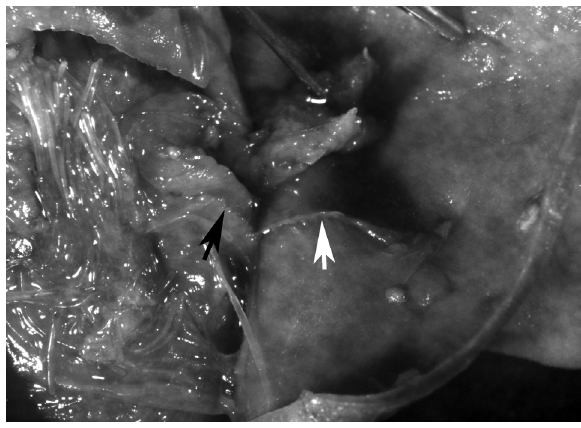
Fig . 6. – Left side of the mantle cavity of Sepiola bursadhaesa n. sp., paratype, MNCN 15.06/226P2, female. The black arrow indicates the shredded line of fusion of the bursa copulatrix to the inner man- tle wall; the white arrow points to the scar of the fusion remaining on the inner mantle wall. Note the very numerous spermatophores in the mantle cavity and several spermatangia, some of the latter implanted on the bursa copulatrix. The velum is also visible.